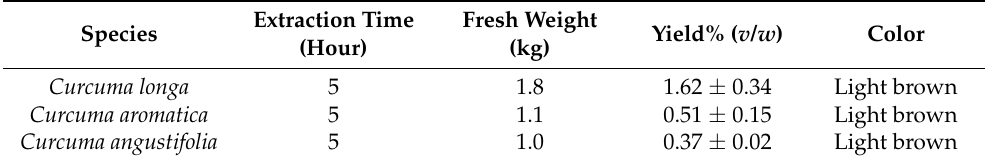
Table 1. Yield and extraction method of essential oils obtained from different species of Curcuma spp. through hydro-distillation. Species